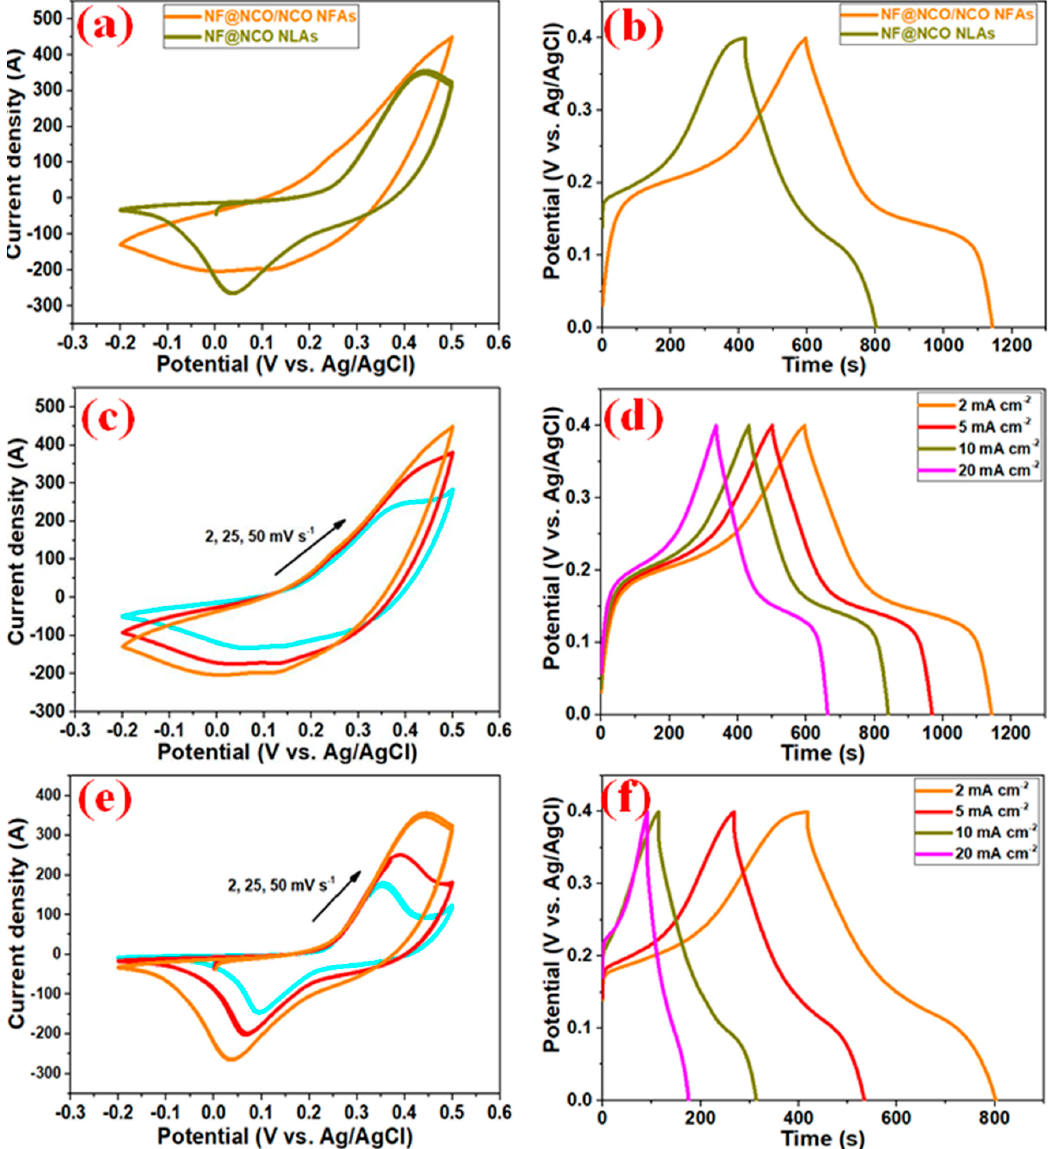
Figure 4. Comparison of ( a ) cyclic voltammetry (CV) and ( b ) galvanostatic charge-discharge (GCD) plots of the NF@NCO NLAs and NF@NCO/NCO NFAs electrodes measured at a constant scan rate and current density. ( c ) CV and ( d ) GCD behaviors of the NF@NCO/NCO NFAs electrodes at various scan rates (2, 25, and 50 mV s − 1 ) and current densities (2–20 mA cm − 2 ). ( e ) CV and ( f ) GCD behaviors of the NF@NCO NLAs electrodes at various scan rates (2, 25, and 50 mV s − 1 ), and current densities (2–20 mA cm − 2 ).